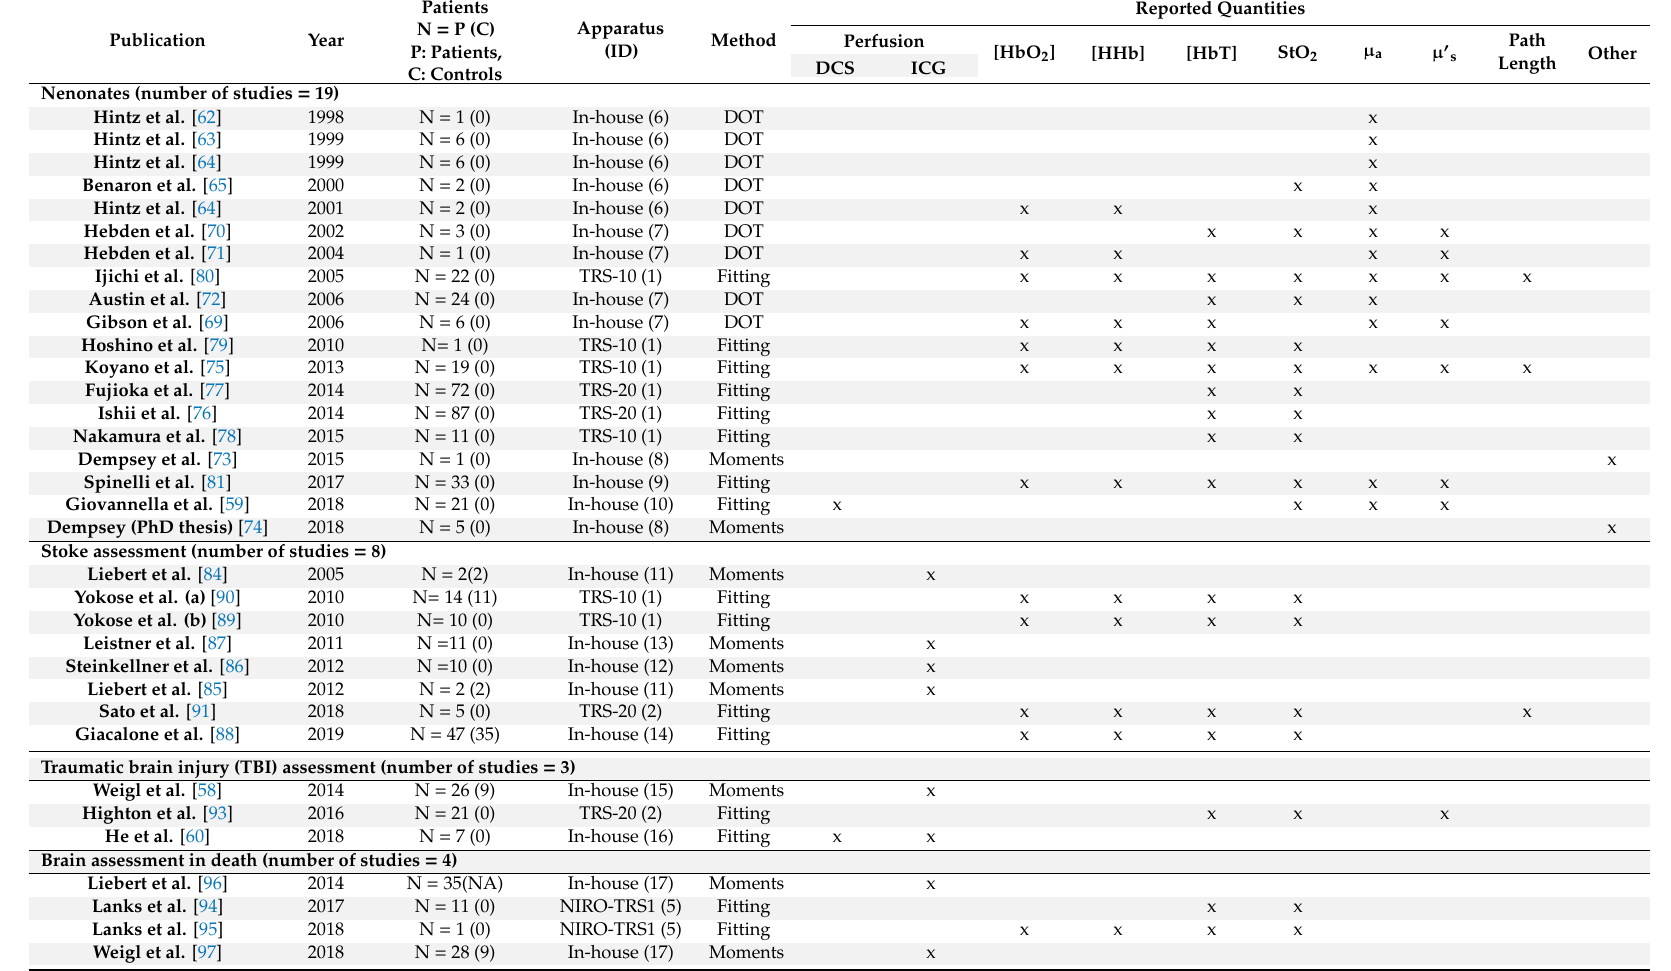
Table 3. Table of the literature review of the use of TD-NIRS for clinical brain